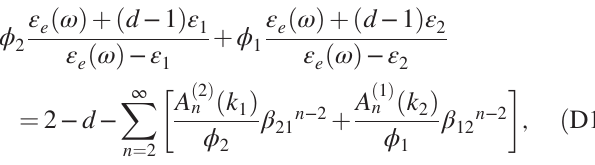
FIG. 13. Evaluation of the effective dielectric constant ε function of the dimensionless wave number k 1 a for 3D equilib- rium packings and 3D Debye random media of volume fraction ϕ 0 . 25 and contrast ratio ε 2 ¼ the wave number in the matrix (reference) phase 1, and a is particle